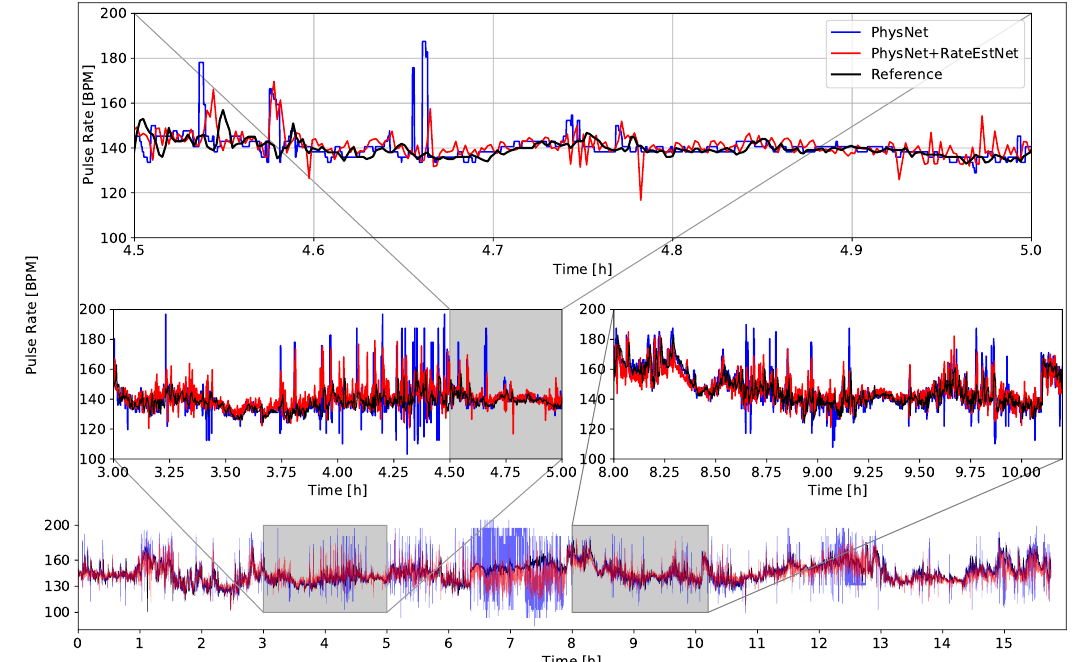
Figure 10. Illustration of model estimates and reference of pulse rates. At the bottom the whole 15-h-long test dataset is plotted. Above that two selected 2-h-long segments are enlarged. Finally, at the top a half-an-hour-long segment is shown. From the bottom plot we can see that the estimation is the worst from 6.5 to 8 h. The explanation for this is that in this part the head of the neonate is covered with sheet, therefore only a small skin area is visible.